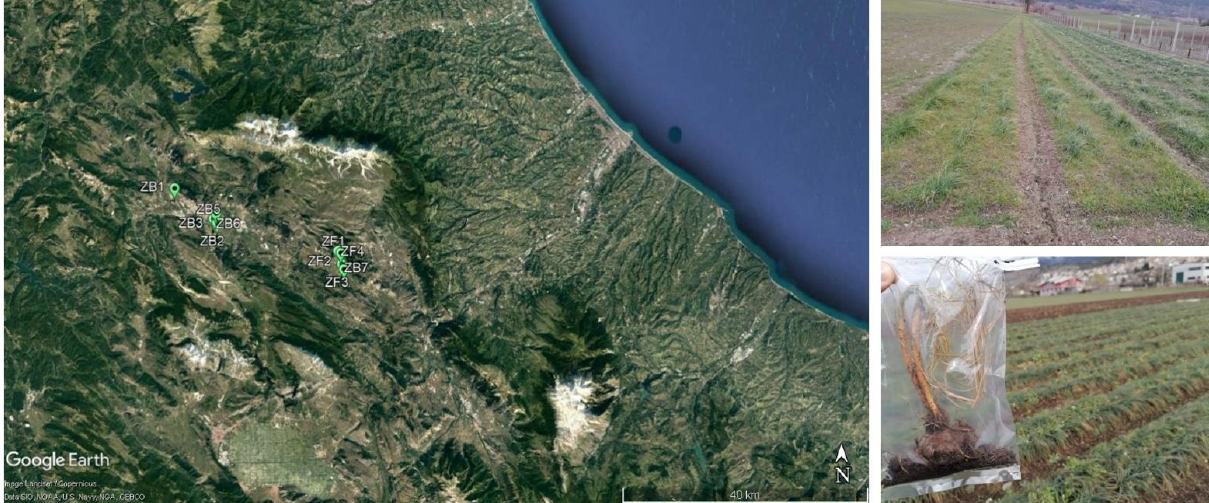
Figure 1. Geolocalization map of the sampling area and examples of a field and a corm with an evident Fusarium pathogenesis.